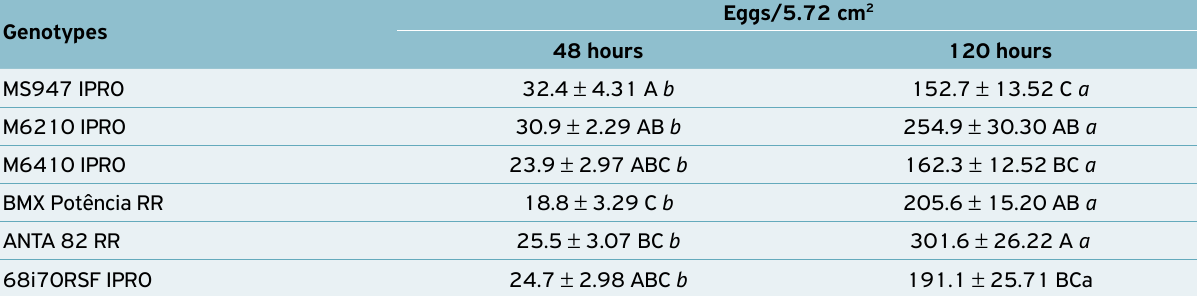
Table 2. Number (mean ± standard error) of eggs of Bemisia tabaci B biotype on six soybean genotypes, in two periods after infestation in choice tests, Dourados (MS), Brazil, 2016.